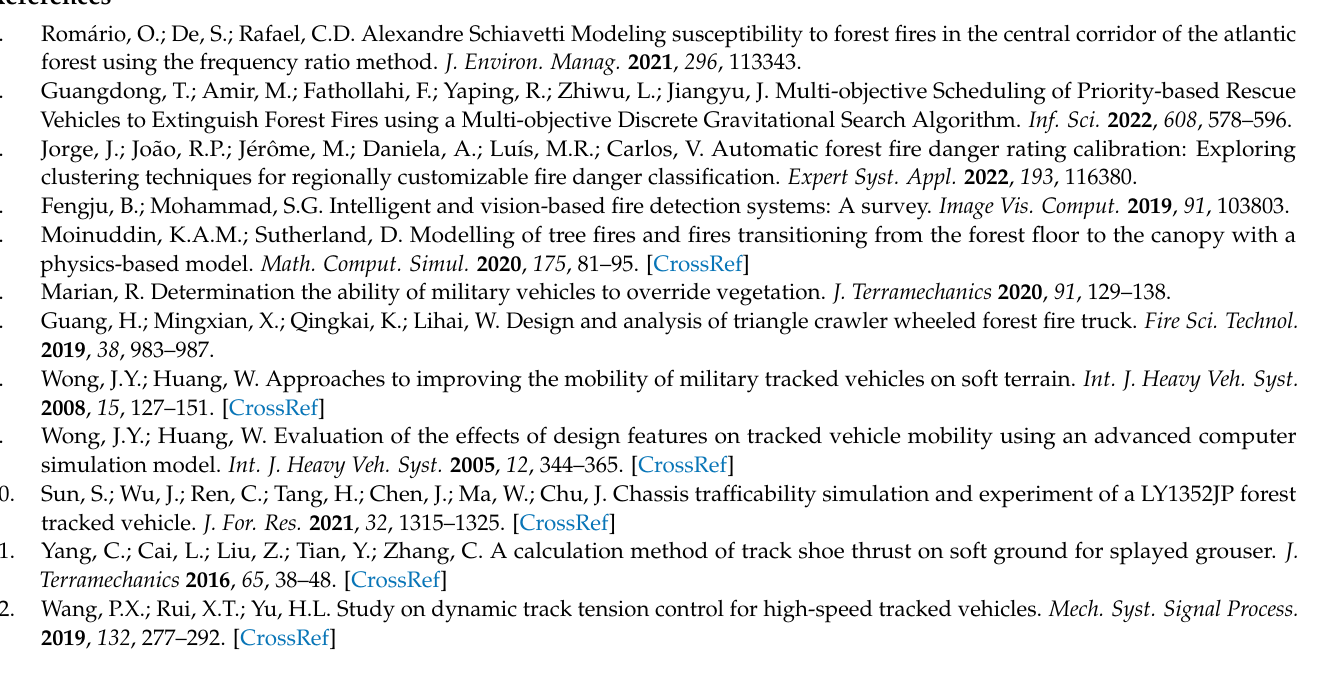
Figure S4: Real vehicle test process (2); Figure S5: Real vehicle test process (3); Figure S6: Real vehicle test process (4); Figure S7: Real vehicle test process (5); Figure S8: the method of 10m elevation measures road